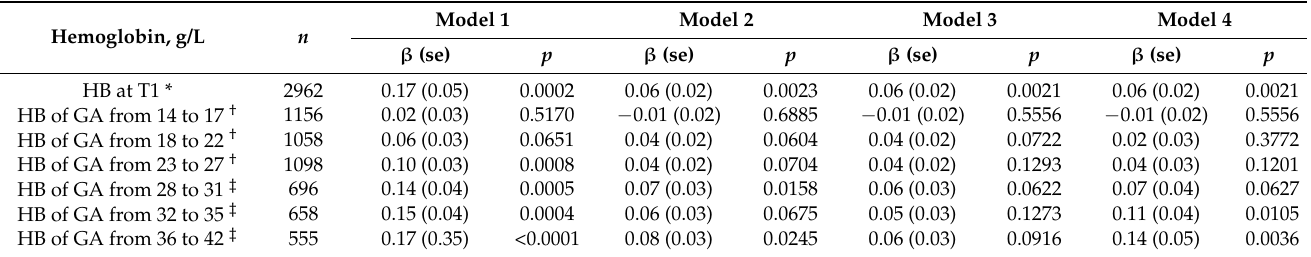
Table 6. The association between 25(OH)D in the first trimester and hemoglobin in different gesta- tional ages.